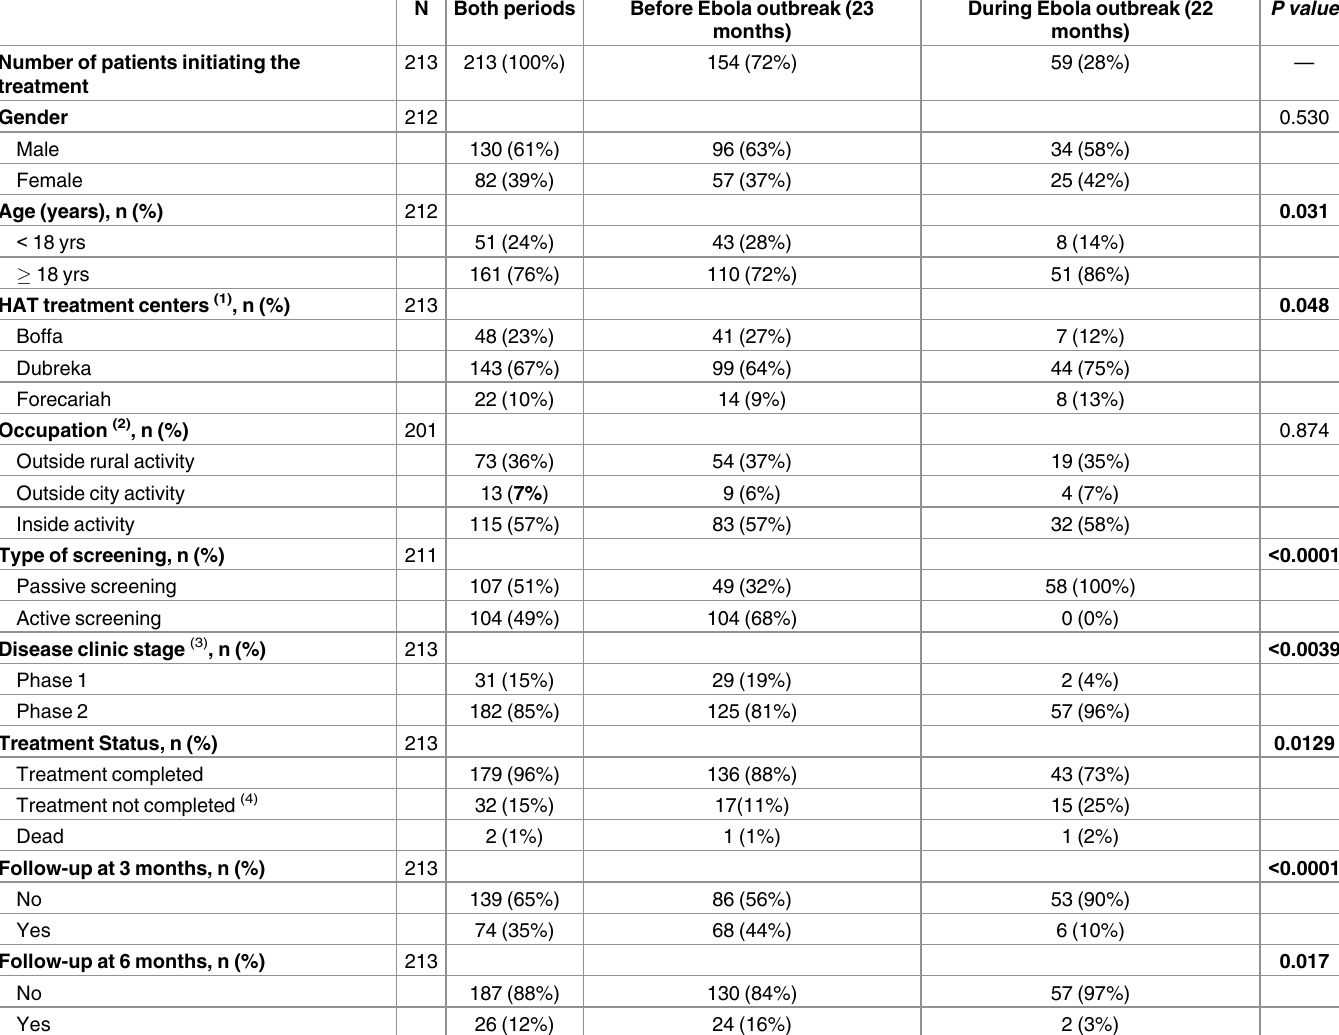
Table 1. Characteristics of the patients treated for HAT before and during Ebola outbreak, Guinea, January 2012to October 2015 (for sensitivity analysis with different split dates between the two periods see S2 Table and S3 Table). N Both